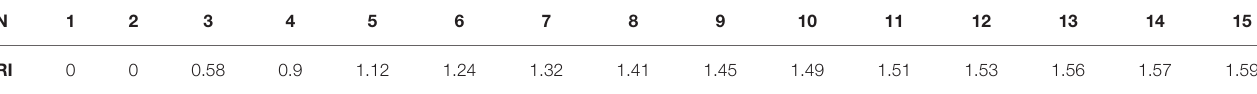
TABLE 7 | Random Index (RI) used in the AHP Method.